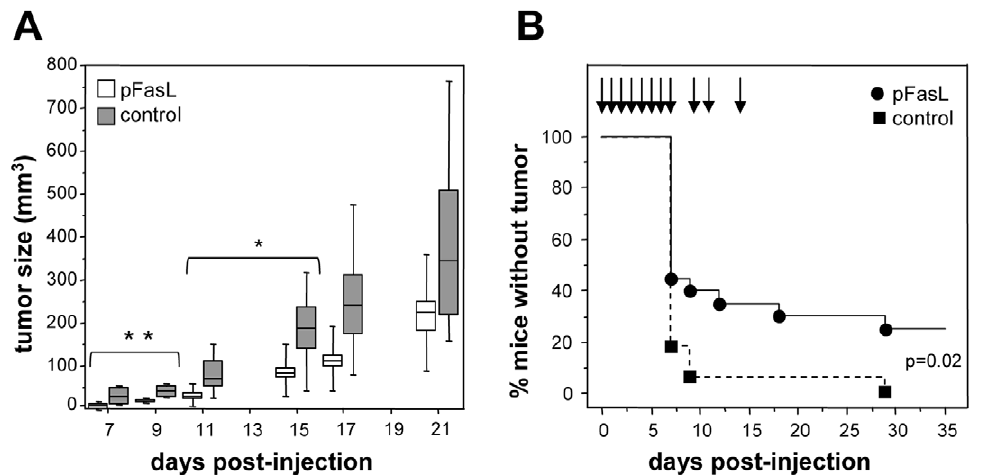
Figure 4. Anti-tumor activity of pFasL. Panel A: Tumor growth in mice having received subcutaneously 10 5 A431 cells at day 0, and 0.1 mL of concentrated pFasL (white boxes) or pFasL-free control (grey boxes) locally at days 2 and 7 (n=6 mice per group). Tumor volumes are expressed in mm 3 . Values are presented as median, 25 th and 75 th percentiles (horizontal line, bottom and top of boxes), and 10 th and 90 th percentiles (bottom and top range bars) (**p=0.04, * p=0.05). Panel B: Kaplan-Meier analysis of cumulative percentage of mice without detectable tumor,, xenografted with A431 cells and treated with pFasL (black circles) or pFasL-free control (black squares) (p=0.02). n=20 mice per group, from two experiments pooled.